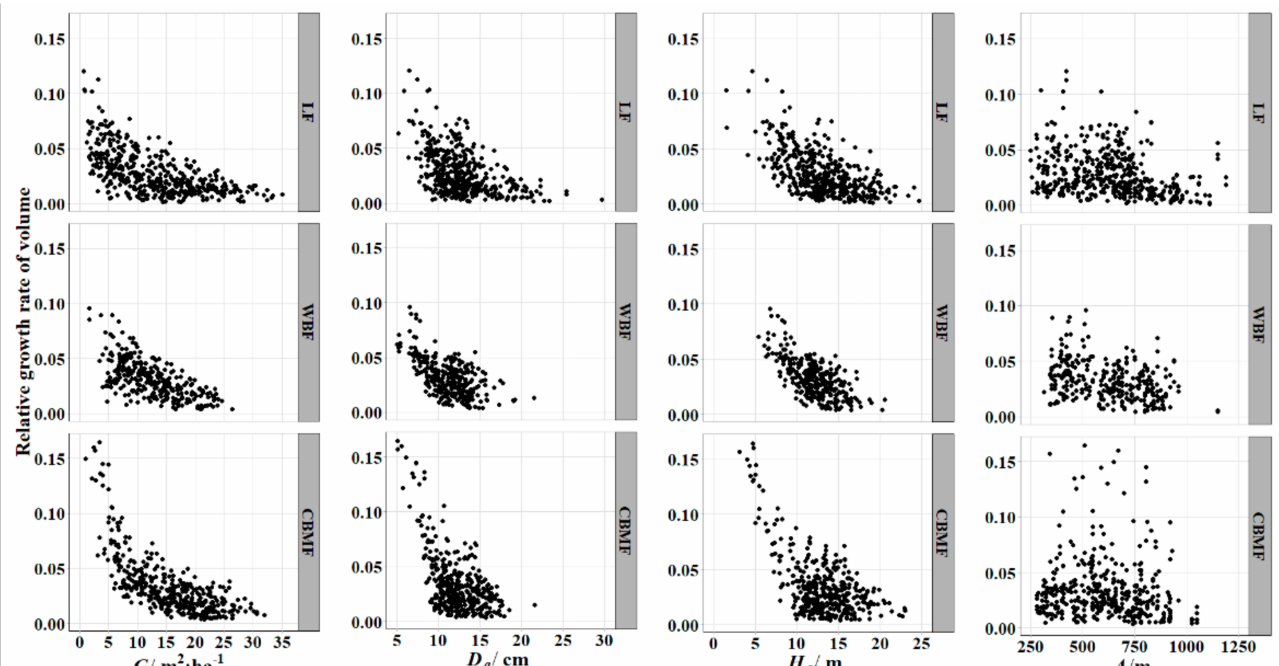
Figure 2. Relationship between the RGR nv and independent variables for LF, WBF, and